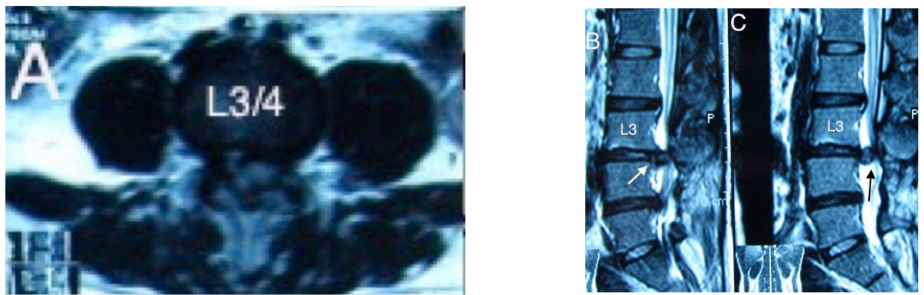
Figure 1. ( A ). The mass occupied most of the spinal canal on cross-sectional imaging MRI. ( B ) Mass in the spinal canal with fused leg to the L3/4 disc and anterior dural discontinuity ( white arrow ). ( C ) intradural herniated mass ( black arrow ).